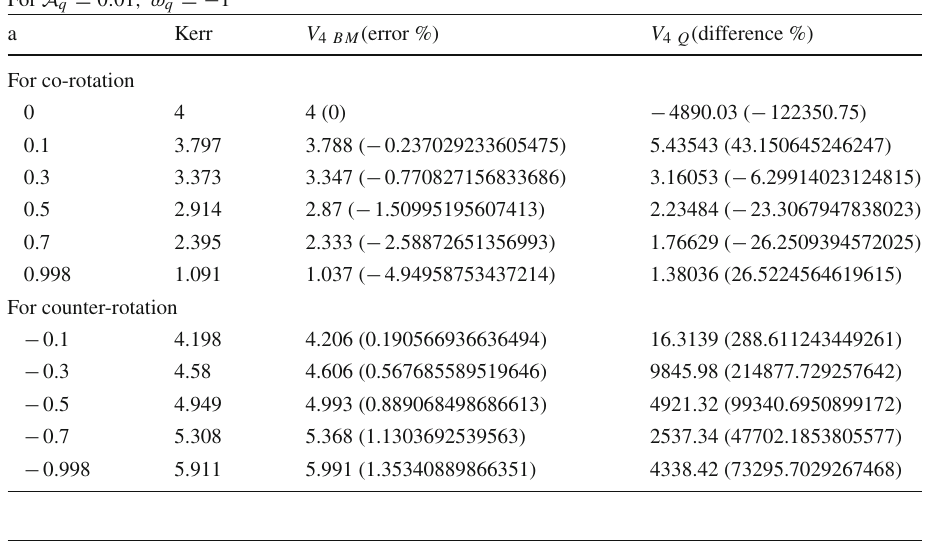
PNPs for moderate DE effect in phantom barrier